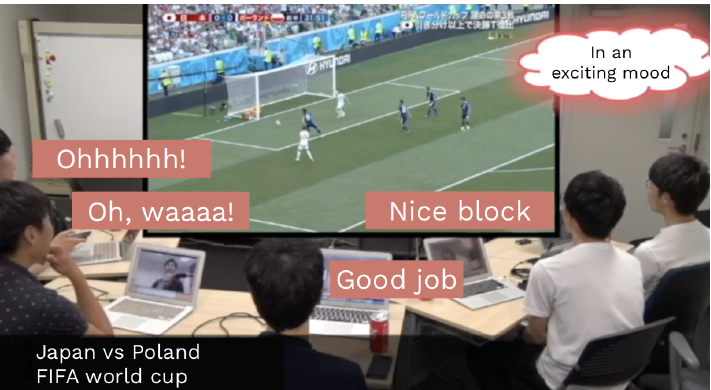
Figure 5. Snapshot of the video recording of excitement levels by participants watching a soccer